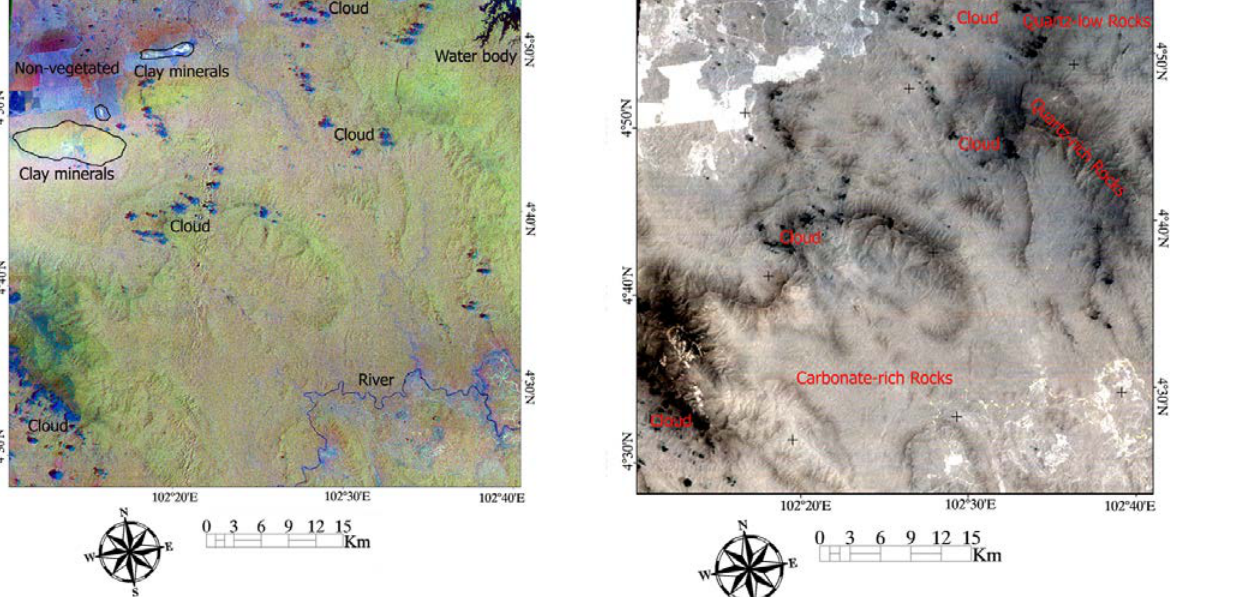
Figure 4. Fused image map of OHI, KLI and ALI indices as RGB color combination derived from ASTER level 2B05S product for the study area.